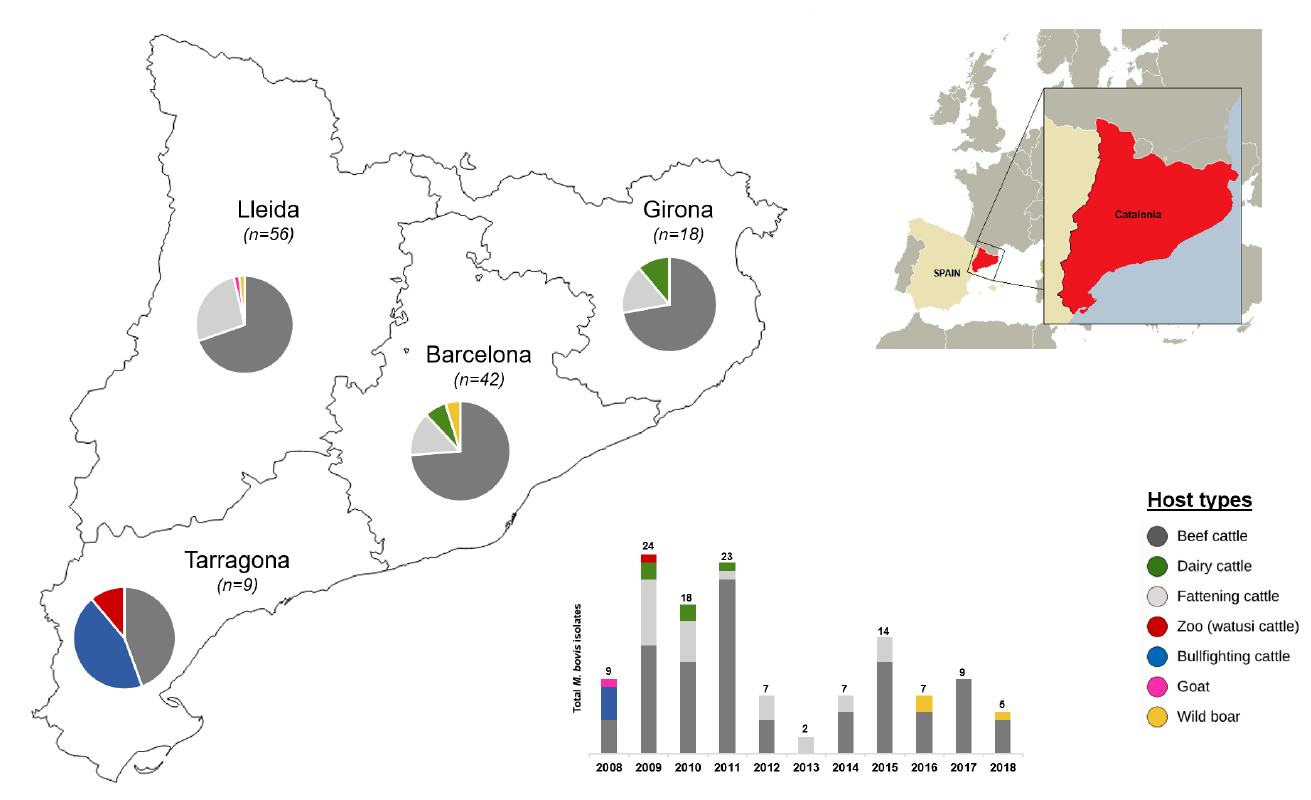
Figure 1. Map of Catalonia showing the origin of the M. bovis isolates with respect to geographic region (province) and host type. The stacked bar chart represents the number of isolates that correspond to each year of isolation (2008–2018). Total number of isolates per region and year are indicated, as well as the proportion of isolates for each host